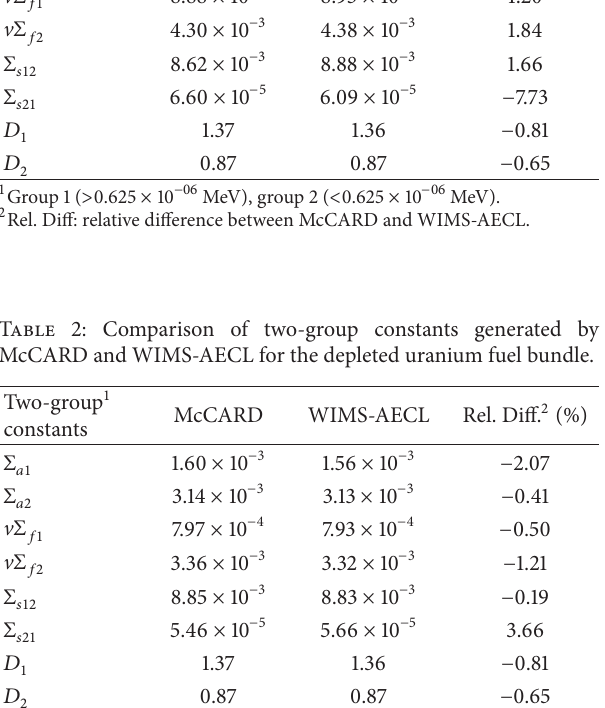
Table 1: Comparison of two-group constants generated by McCARD and WIMS-AECL for the natural uranium fuel bundle.